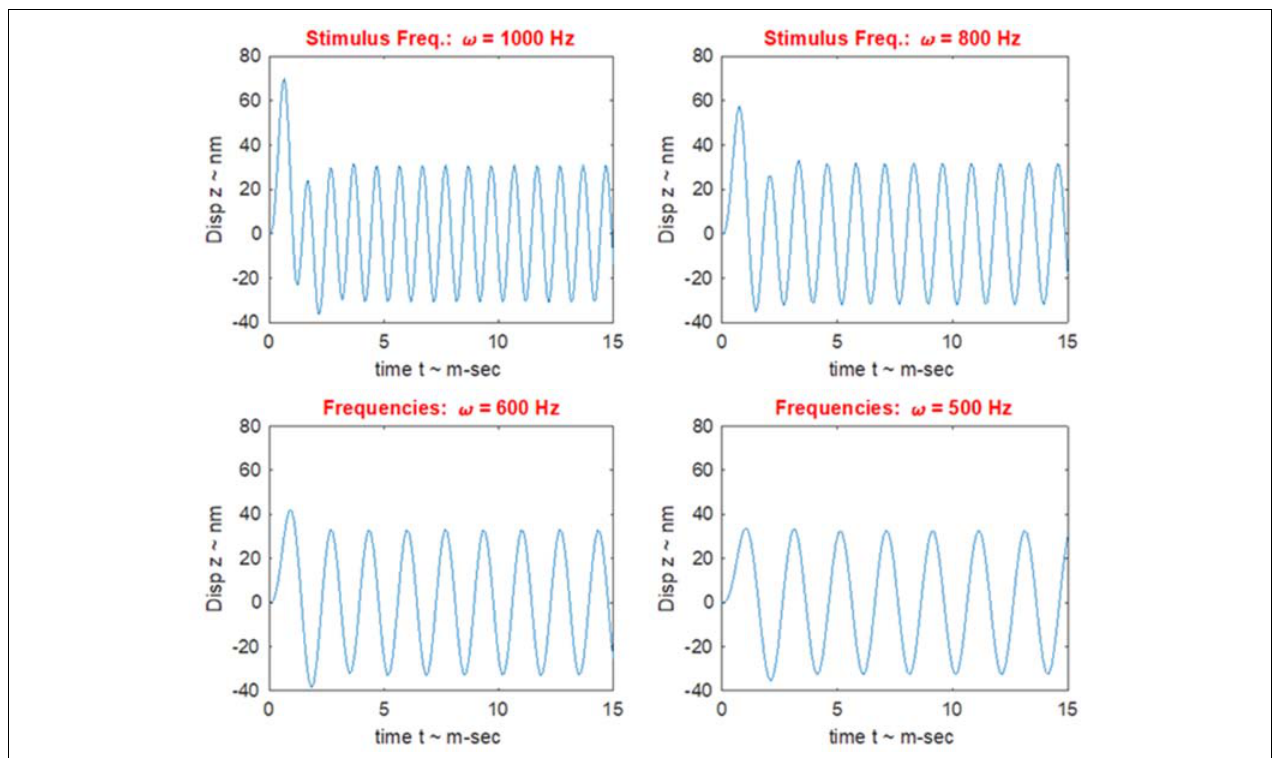
FIGURE 13 | Relative Displacement z vs. time t response curves, for solutions of Eqn. 11, the equations of motion for relative displacement between OL and NEL. Parameter for this solution: UDNF of 400 Hz (human estimate from above), damping ratio of 0.5 (value measured in the turtle; Dunlap and Grant, 2014), and with a NEL maximum displacement of 50 nm (estimate for a VEMP stimulus; Grant and Curthoys, 2017). The solutions were obtained numerically using MATLAB and show significant transient displacement response at the onset of the response when the stimulus frequency ω , indicated in red above each curve, is well above the UDNF. As can be seen in the 1000 and 800 Hz curves, the transient displacement is above the maximum stimulus value of 50 nm. The transient is present with a 600 Hz stimulus, and almost absent at 500 Hz.